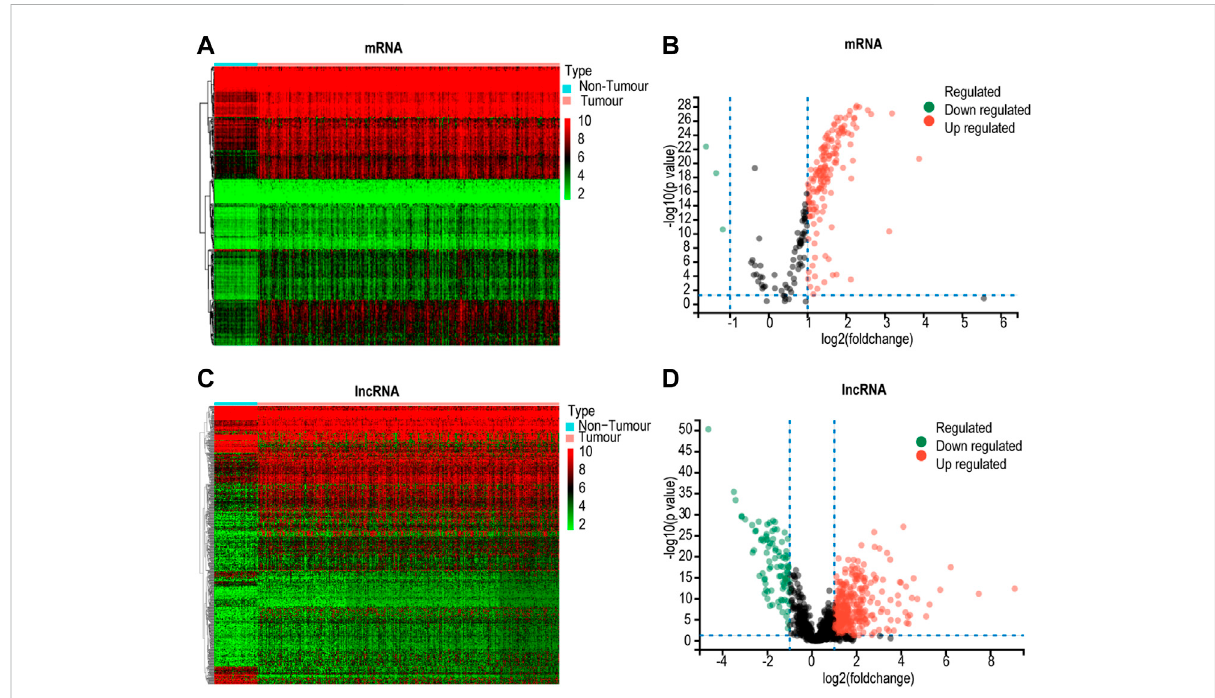
FIGURE 2 Screening for differentially expressed lactate genes. (A) Heatmap for differential lactate mRNAs. (B) Volcano plot for differentially expressed lactate mRNAs. (C) Heatmap analyses for differential lactate lncRNAs. (D) Volcano plot for differentially expressed lactate